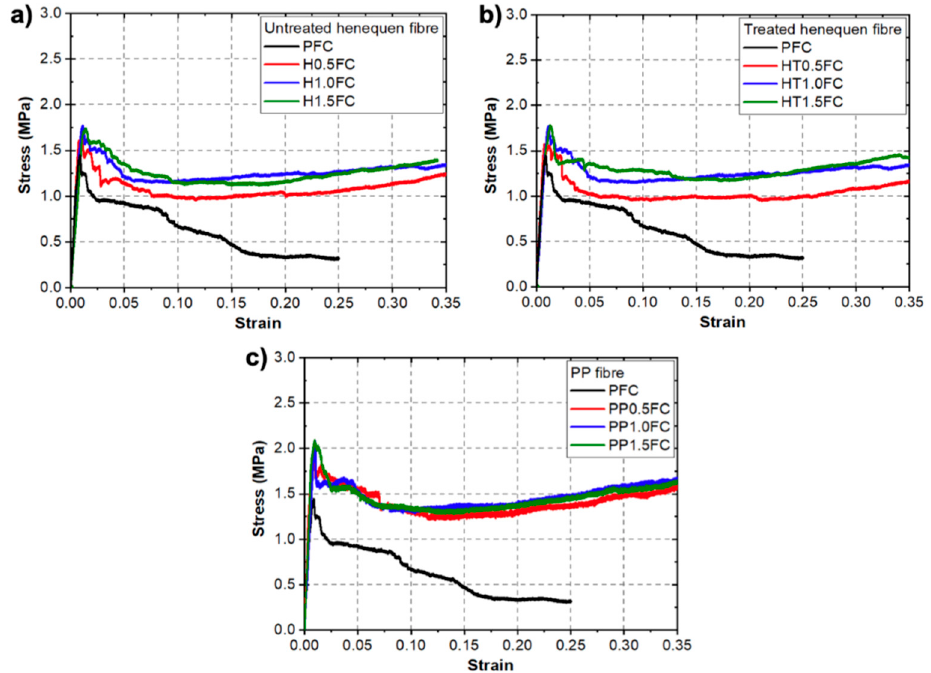
Figure 2. Typical uniaxial compression stress–strain curves for reinforced foamed concrete mixtures with different fiber-reinforcements and volume fractions. A stress–strain curve of the plain foamed concrete (PFC) is included in each figure for comparison purposes: ( a ) untreated henequen fiber; ( b ) treated henequen fiber and ( c ) PP fiber.